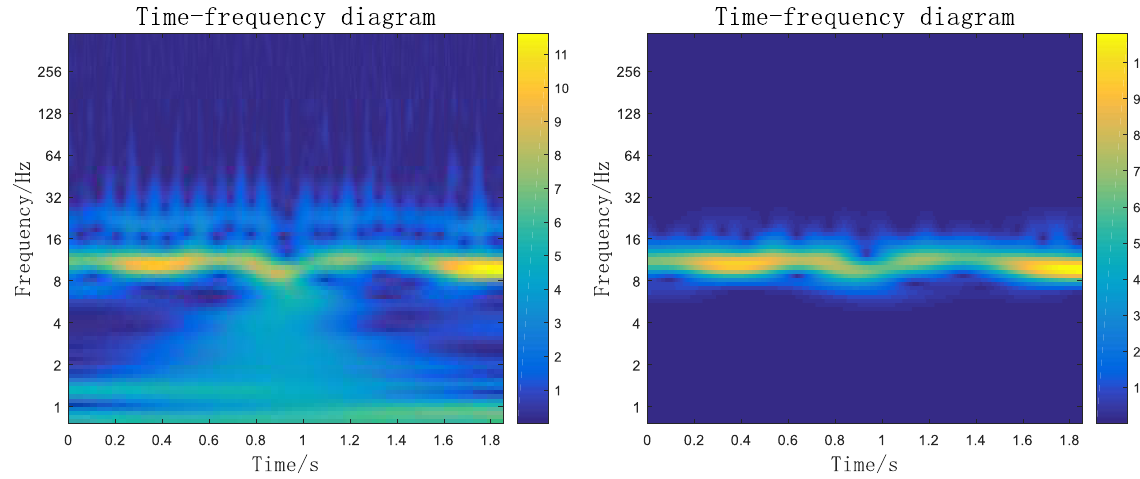
Figure 8. Time-frequency image of sequences and TF image after wavelet reconstruction 4